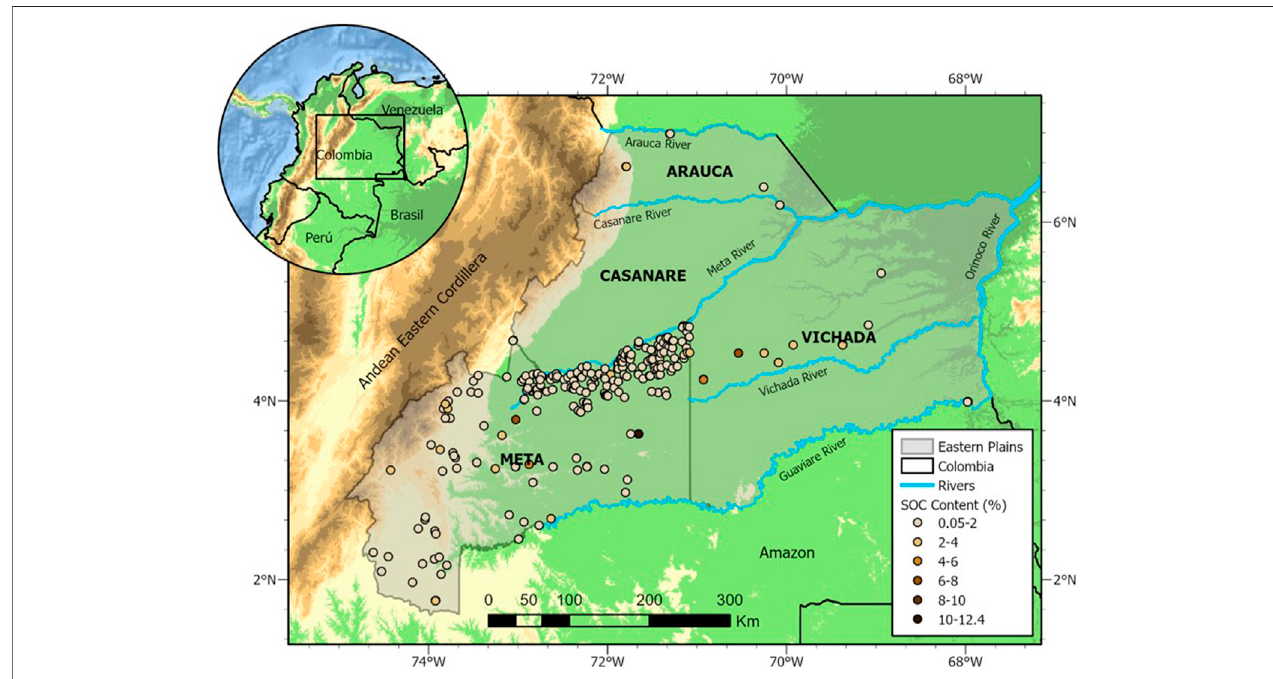
FIGURE 1 | Distribution of soil samples in the Eastern Plains used to build the spatial predictive maps of soil organic carbon (SOC) content and stock.